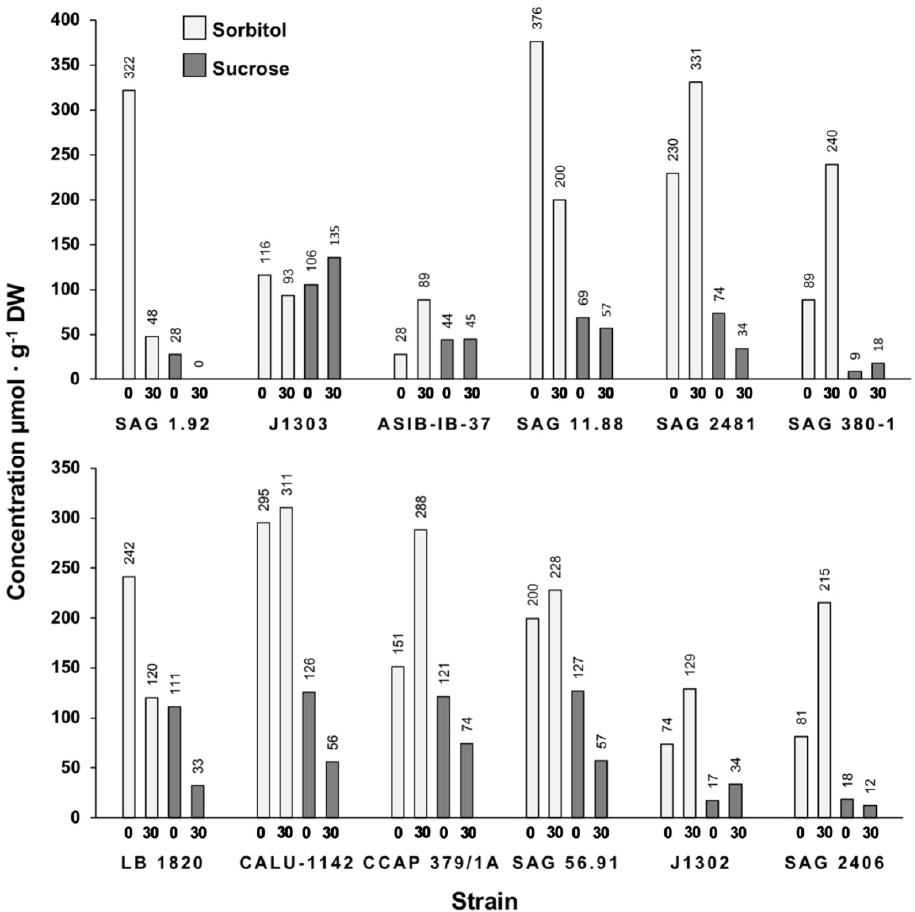
Figure 5. Proportions of the major osmolytes present in each strain during growth at 0 and 30 S A . Concentrations are expressed as µmol g − 1 dry weight